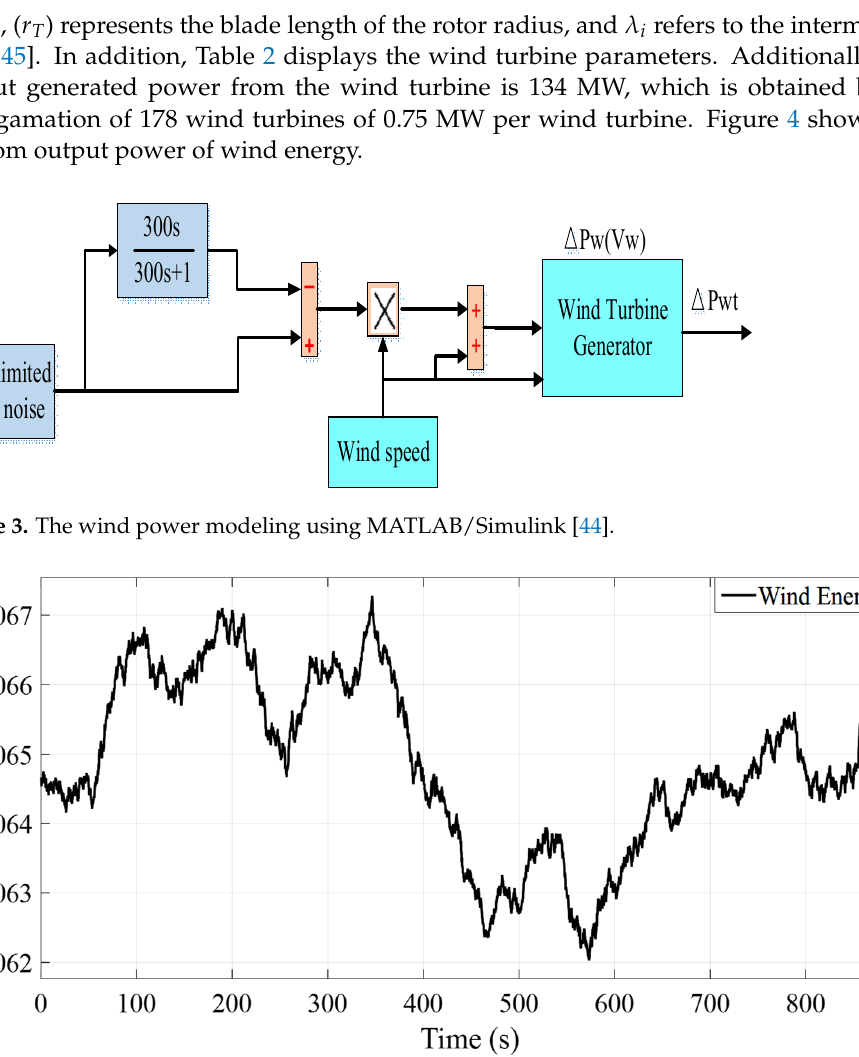
Figure 4. The output power from the wind power model. Table 2. The nominal parameters of the wind farm [44].